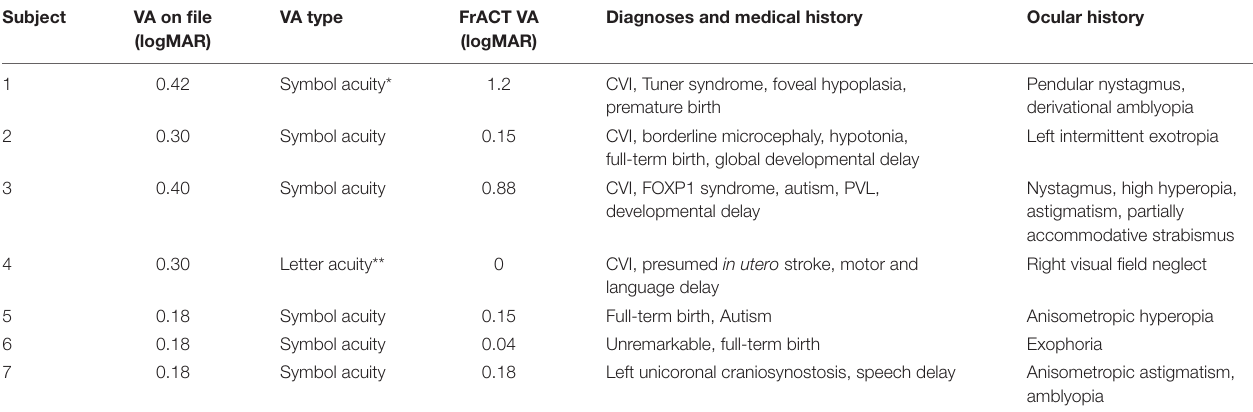
TABLE 1 | Summary of participants medical history and clinical characteristics.